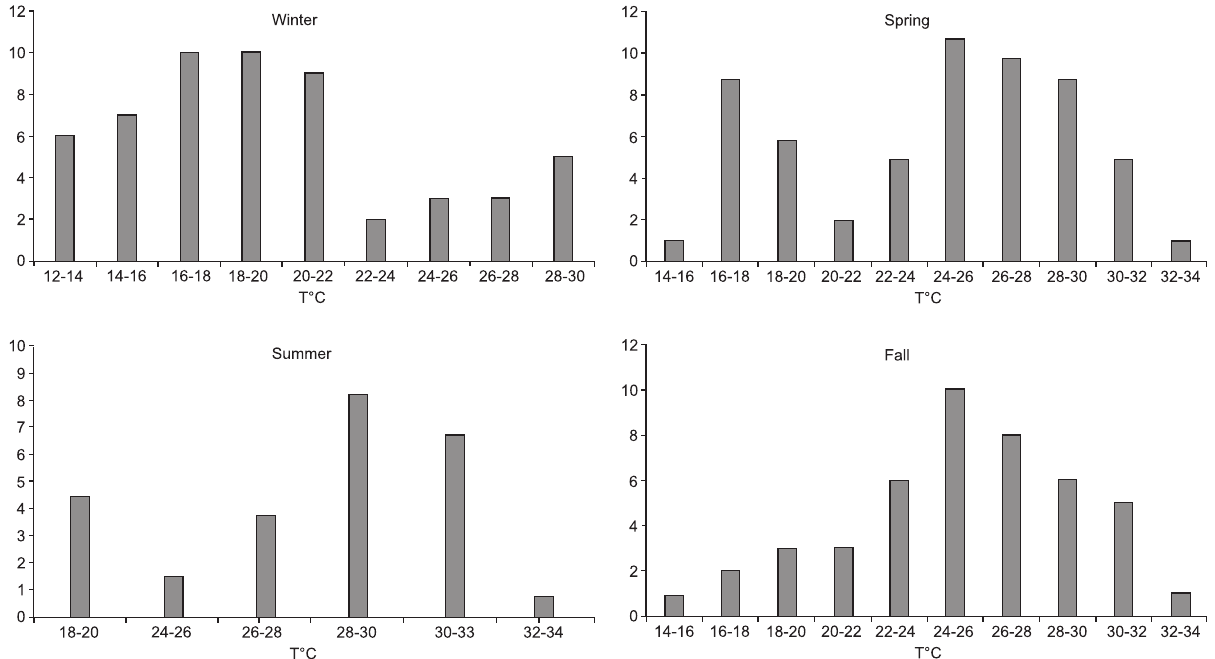
Figure 5. Seasonal frequency distribution of the body temperatures of Amphisbaena munoai found at São Jerônimo between March 2011 and October 2012 (n = 185).